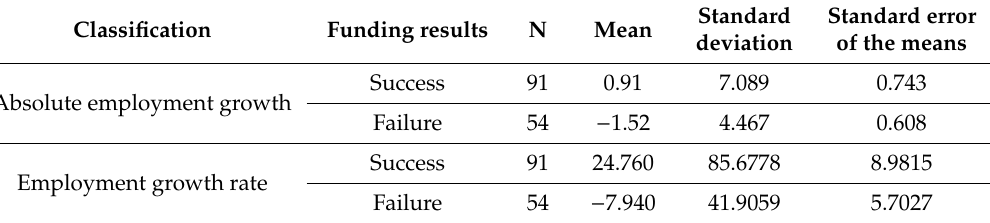
Table 7. Descriptive statistics for employment outcomes.